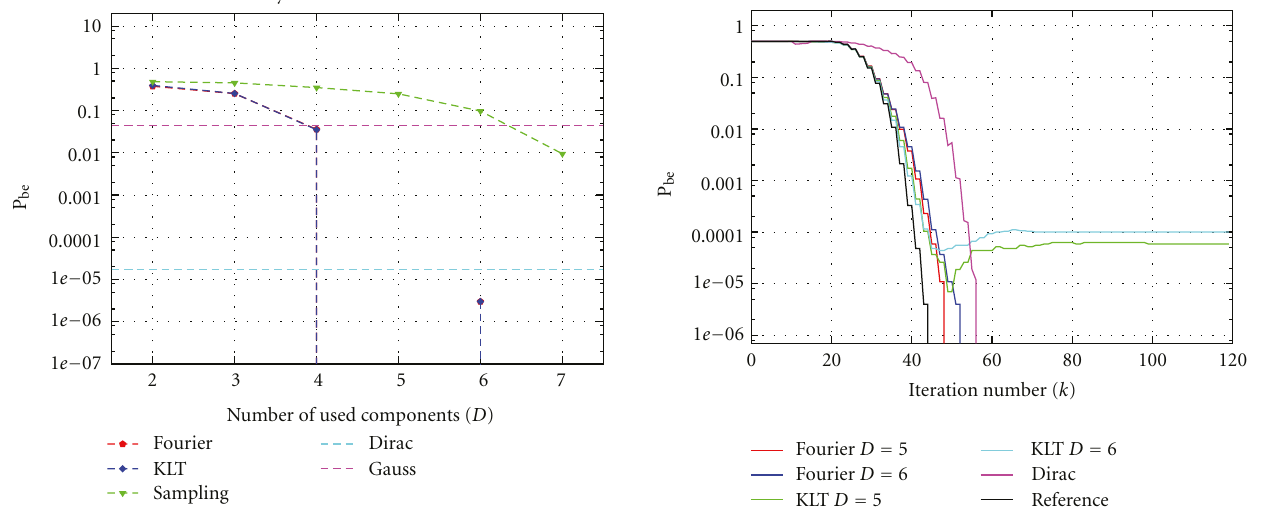
Figure 11: BER of the BICM for di ff erent message